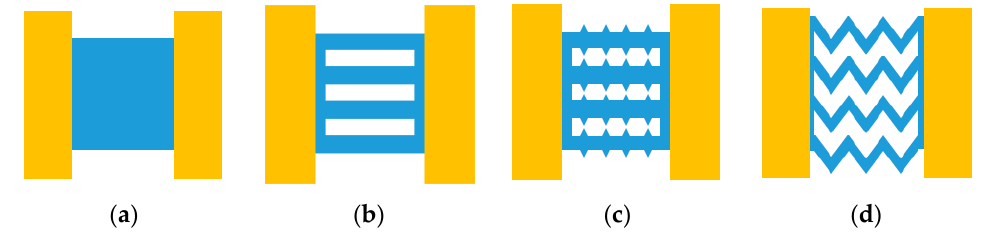
Figure 14. Four types of EC elements. ( a ) shape A; ( b ) shape B; ( c ) shape C; ( d ) shape D.